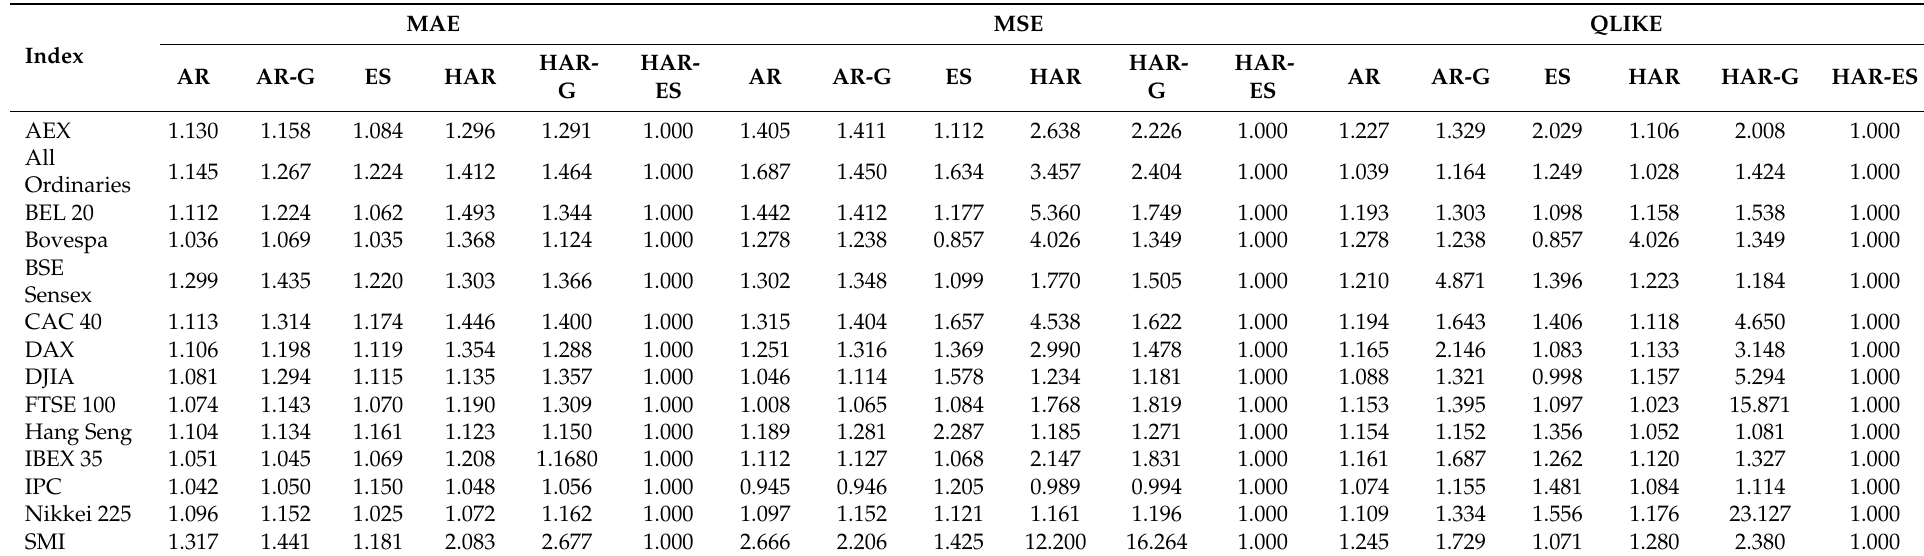
Table 6. Out-of-sample average